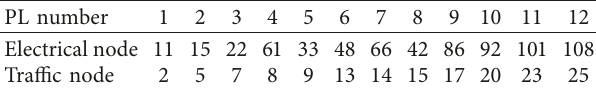
Table 2: Overlap of traffic and electrical nodes containing